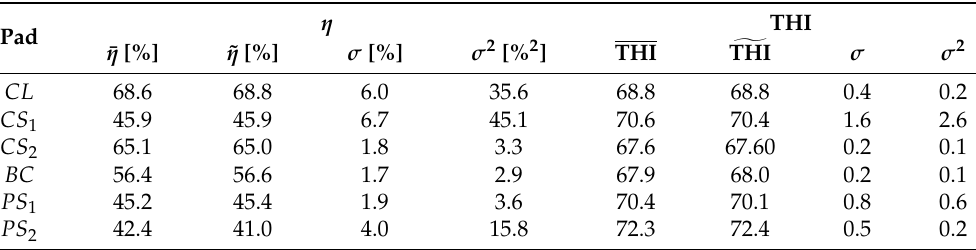
Table 4. Statistical descriptions of the cooling efficiency ( η ) and the Temperature–Humidity Index (THI) for the wind tunnel tests. ¯ η and THI are the means, ˜ η and ˜THI are the medians, σ is the standard deviation and σ 2 is the variance.